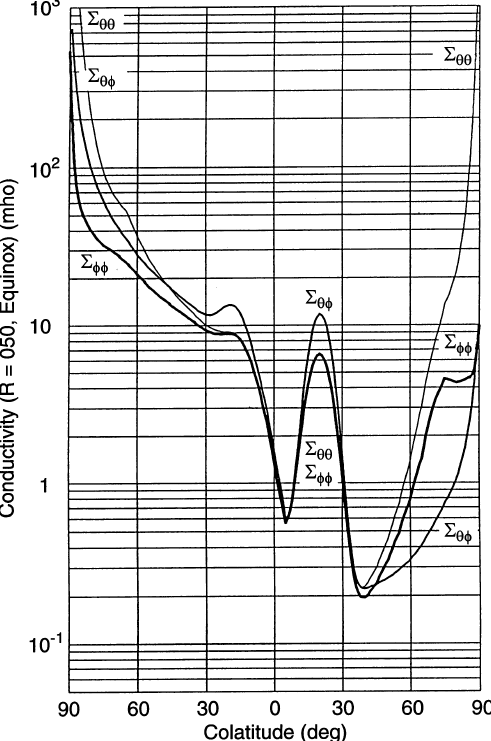
Fig. 1. Noon-midnight profile of S height-integrated conductivity tensor for the condition on equinox with sunspot number 50 for IRI parameters. The abscissa is colatitude numbered from ) 90 at the dayside equator ( left side ) to 90 at the nightside equator ( right side ). The large values of S in the equatorial region are not plotted in